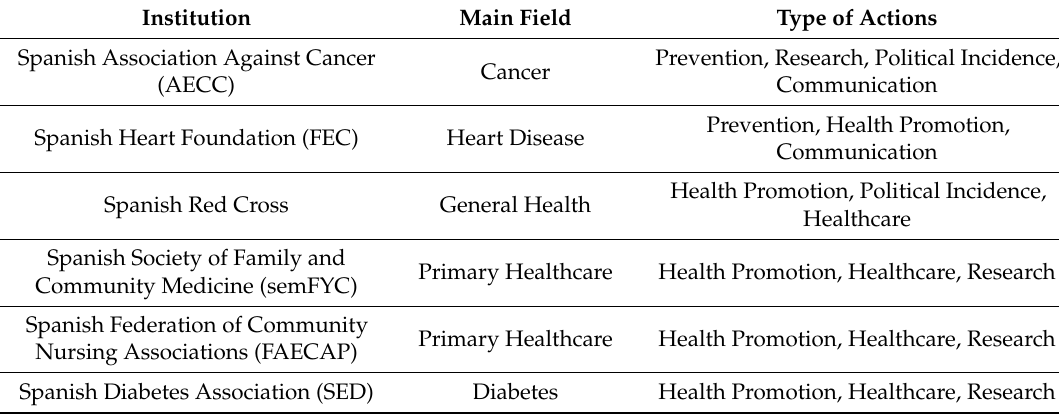
Table 1. Founding partners of the platform, main field and type of actions on non-communicable